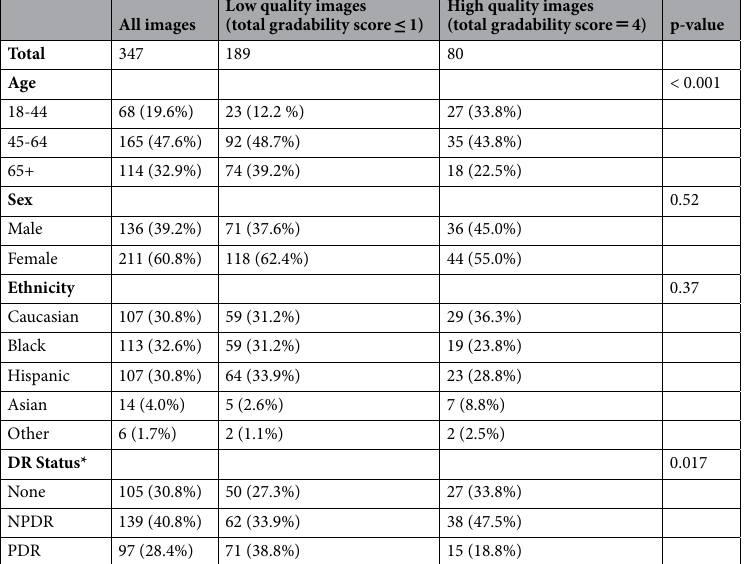
Table 1. Patient characteristics for OCTA images show that patient age and diabetic retinopathy status is significantly associated with image quality, but sex and ethnicity are not. P-values were calculated using the chi-square statistic. DR diabetic retinopathy, NPDR nonproliferative diabetic retinopathy, PDR proliferative diabetic retinopathy. * Diabetic retinopathy status could not be accurately determined for 6 images, which have been